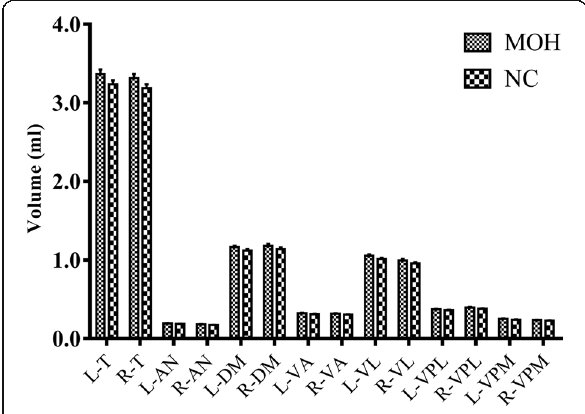
Fig. 3 The mean volume of thalamic subnuclei in MOH and NC. L, left; R, right; AN, anterior nucleus; DM, doromedial nucleus; VA, ventral anterior nucleus; VL, ventral lateral nucleus; VPL, ventral posterior lateral nucleus; VPM, ventral posterior medial